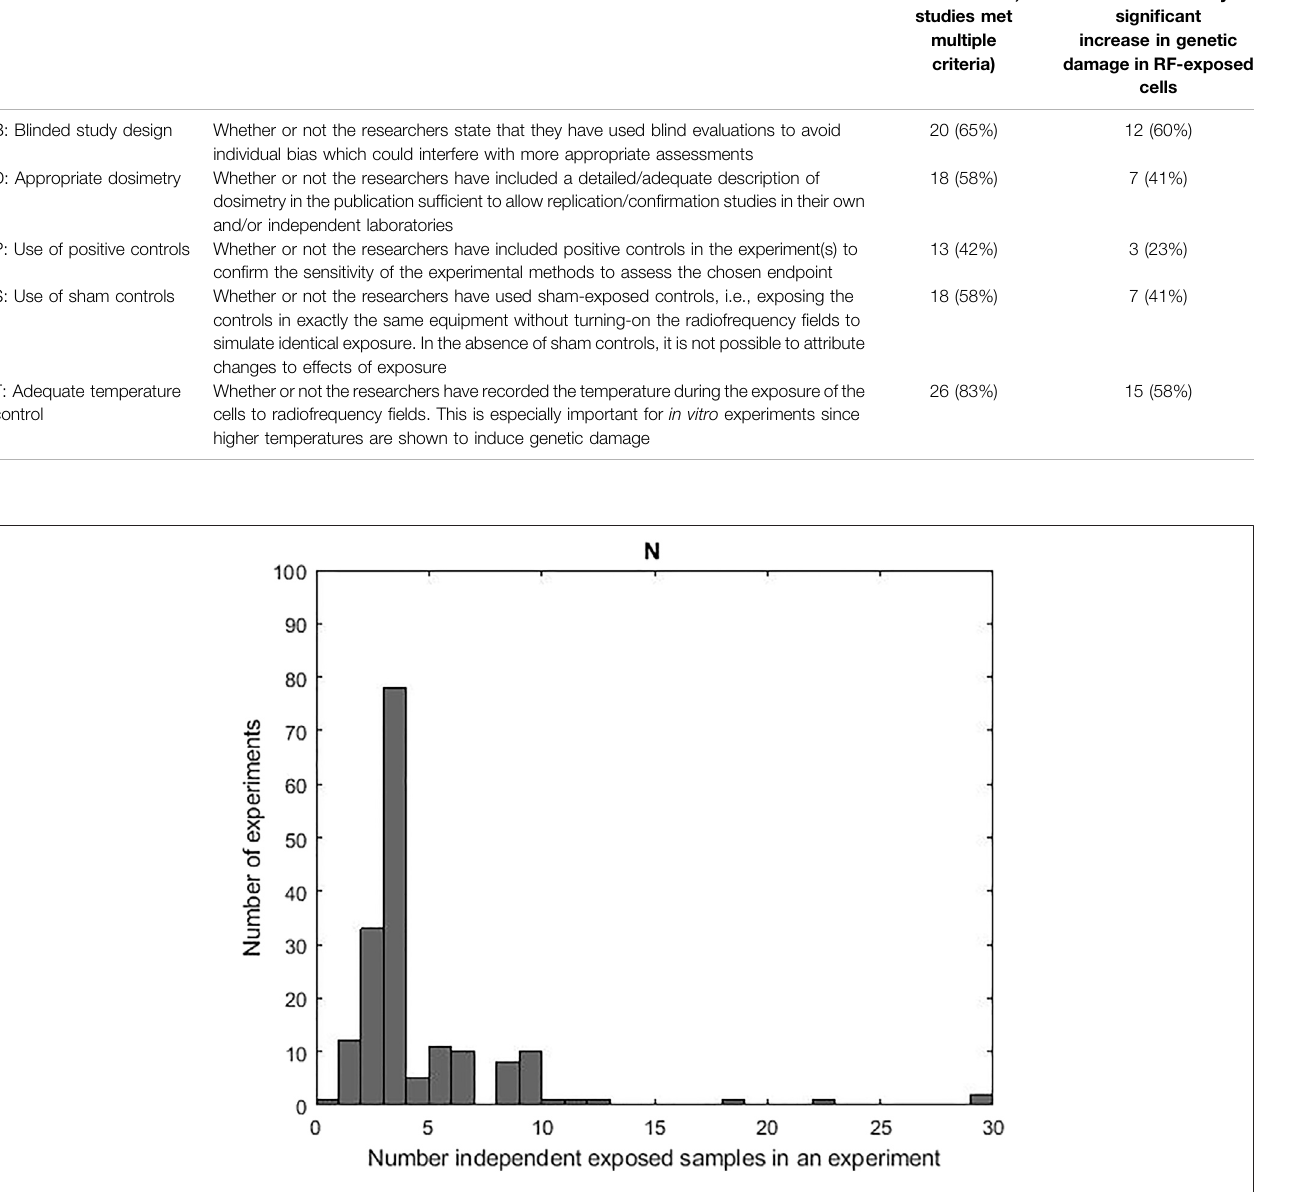
Frontiers in Communications and Networks |